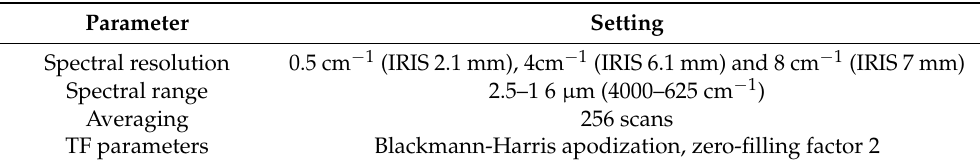
Table A4. Principal parameters used for the setup at ONERA.